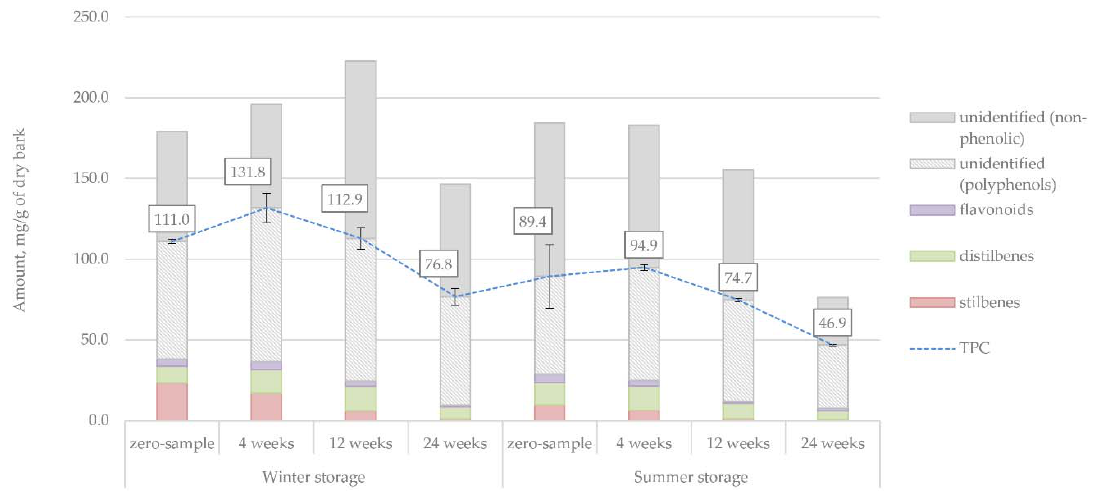
Figure 18. The total phenolic content (TPC) of the water extracts. The values of stilbenes, distilbenes, flavonoids and unidentified compounds from the GC analyses, as seen in Figure 5, are shown for reference.